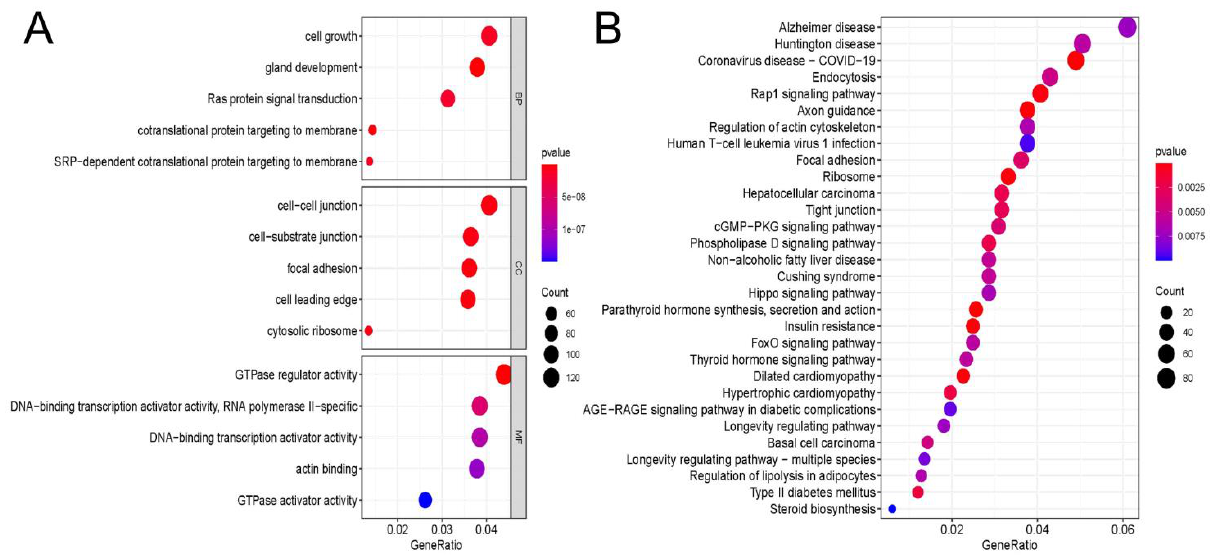
Figure 3. GO and KEGG analyses of m6A peaks: ( A ) Major Gene Ontology terms were significantly enriched for the hypermethylated and hypomethylated genes. ( B ) The top 30 significantly enriched pathways for the hypermethylated and hypomethylated genes.